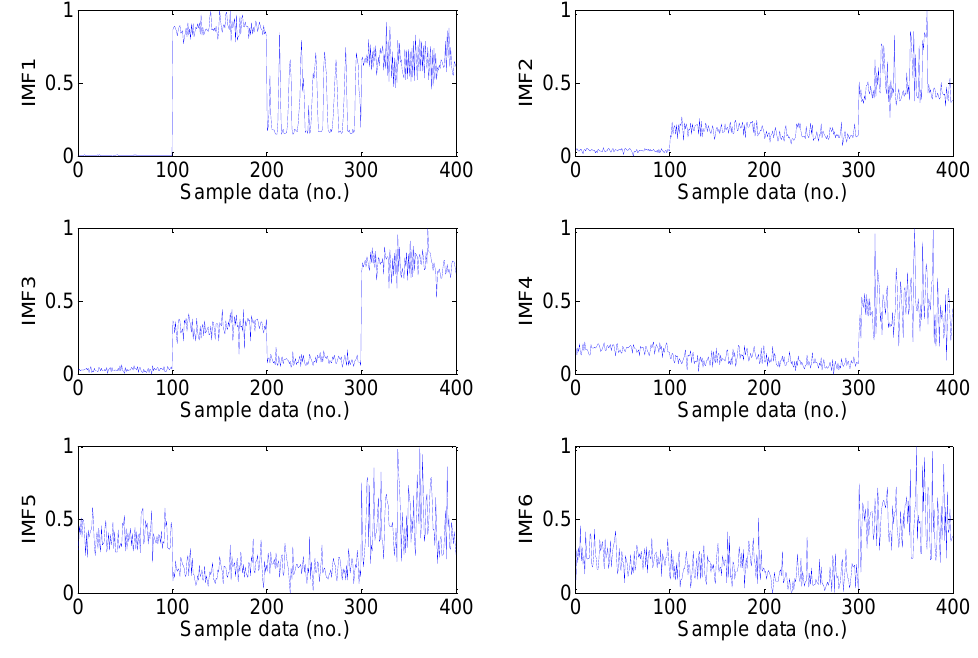
Figure 9. The normalized amplitude energy features value of the first six IMFs by EMD method (Note: sample data No. 1–100, 101–200, 201–300, 301–400 represent normal, inner race fault, ball fault and outer race faults,